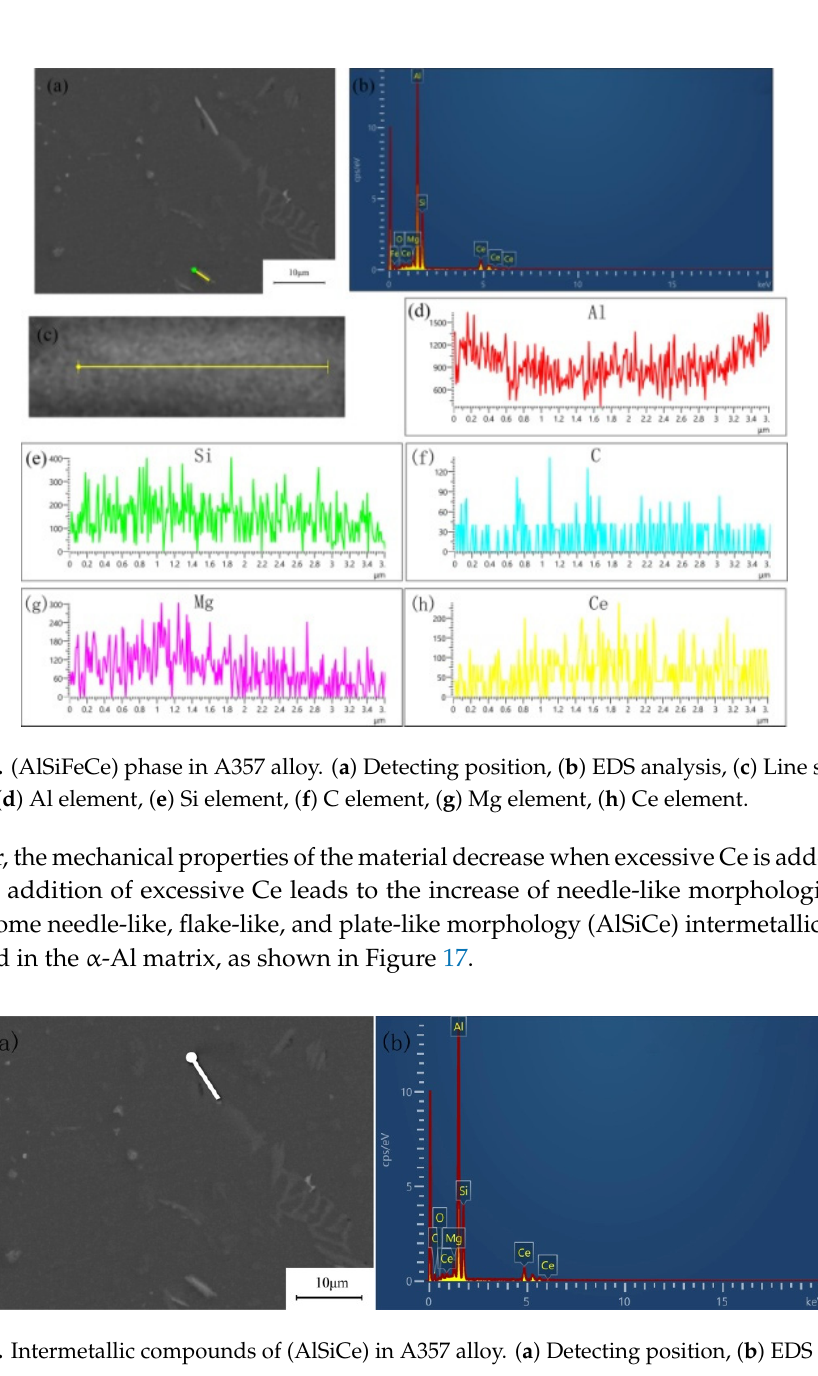
Figure 17. Intermetallic compounds of (AlSiCe) in A357 alloy. ( a ) Detecting position, ( b ) EDS analysis.